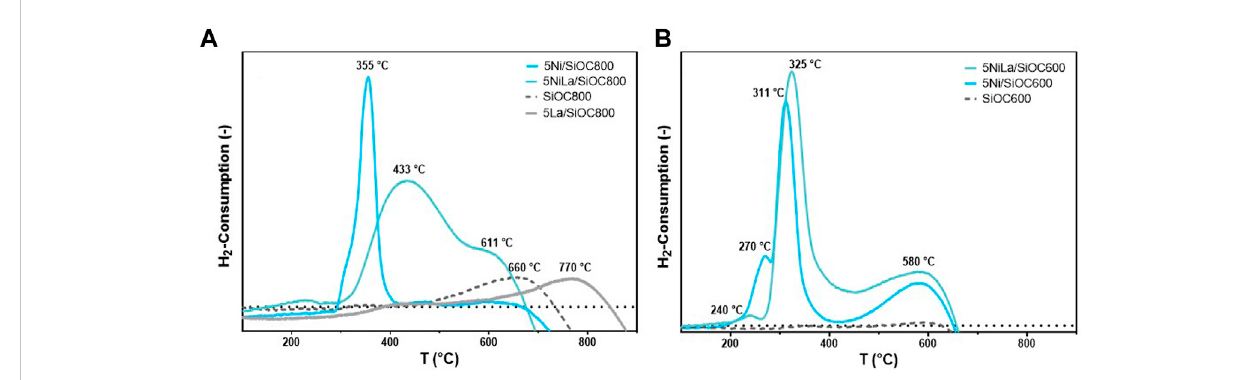
FIGURE 4 H 2 -TPR pro fi les of catalysts with and without La-modi fi cation supported on SiOC pyrolyzed at 800 ° C (A) and 600 ° C (B) .